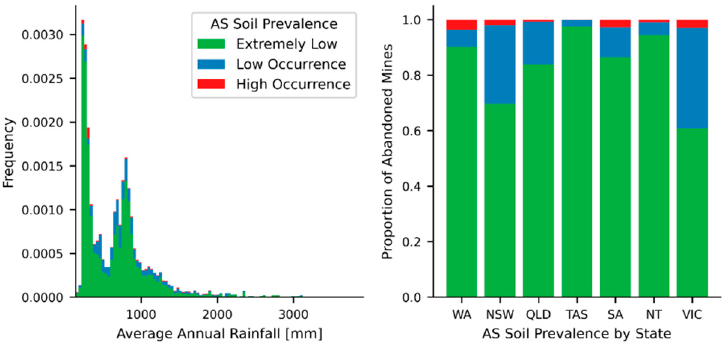
Figure 7. Relationship between average annual rainfall and acid sulphate (AS) soil prevalence of abandoned mines across Australia, overall national perspective ( left ) and state-by-state breakdown ( right ) of the proportion of mines within high, low and extremely low occurrence areas.